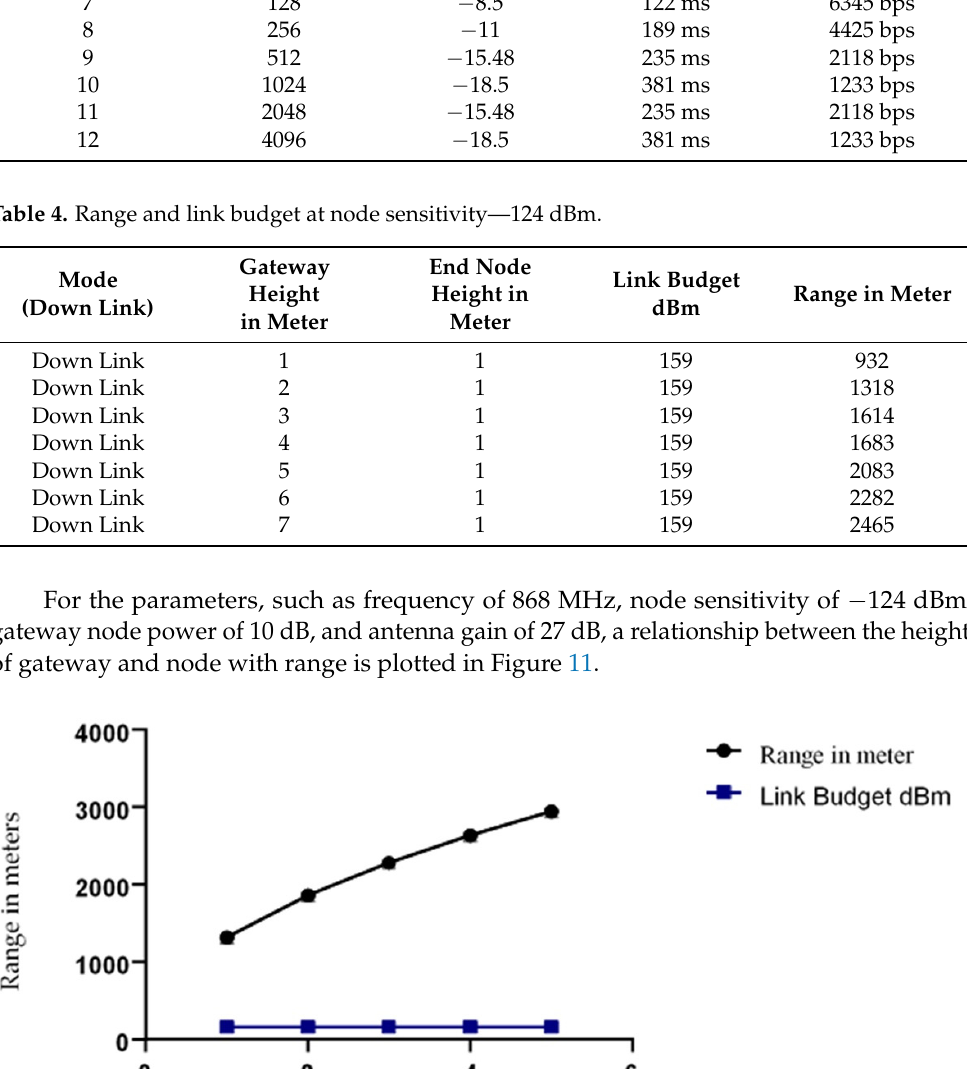
Table 3. Adaptive data rate of LoRa.